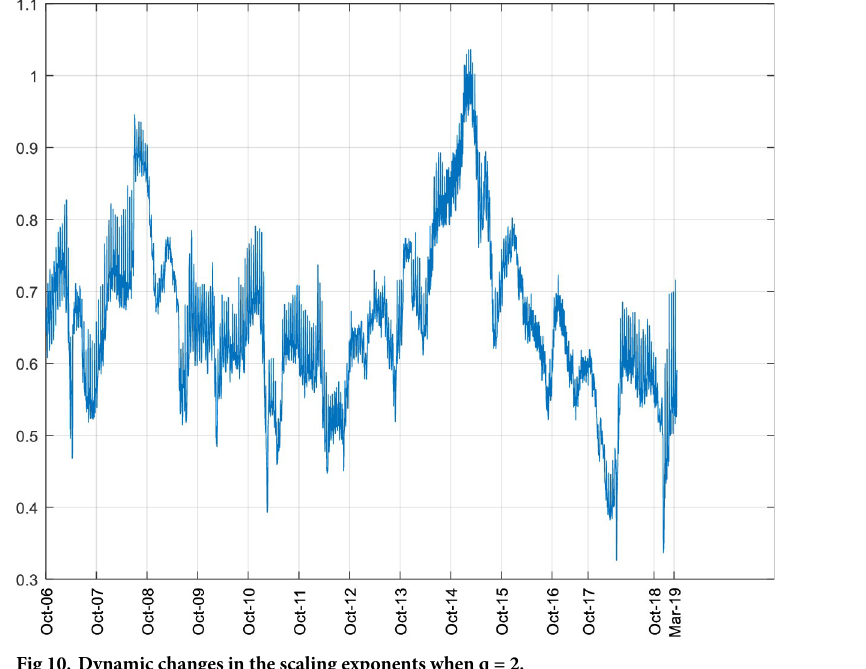
Fig 10. Dynamic changes in the scaling exponents when q =